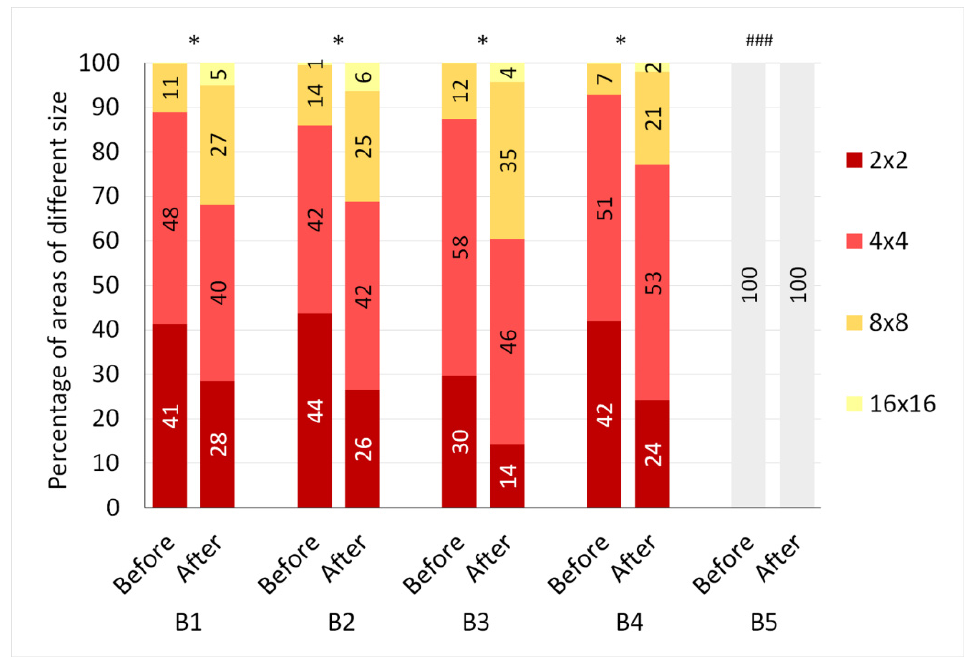
Figure 5. Percentage of homogeneous areas of different sizes in images of B1–B5 dyes before and after the Q ‐ Switched Nd:YAG laser application; * p < 0.001 (Chi2); ### a fully homogeneous area for an arbitrary homogeneity criterion.